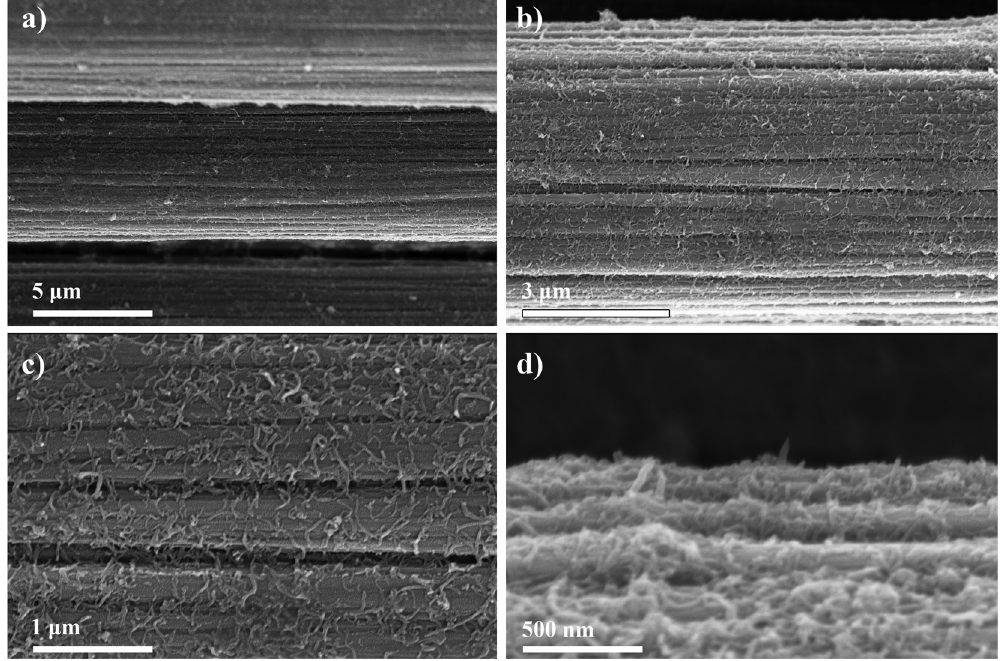
Figure 3: SEM images of hybrid CF – CNT with magni fi cations of ( a ) 20,000 × , ( b ) 40,000 × , ( c ) 1,00,000 × , and ( d ) 2,00,000 ×